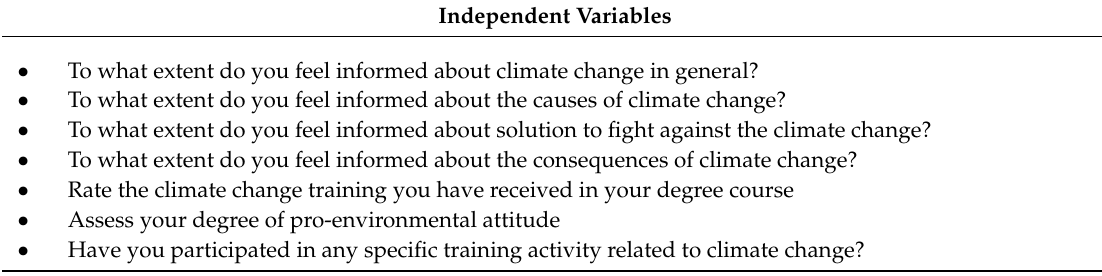
Table 6. Questionnaire questions considered Independent Variables.